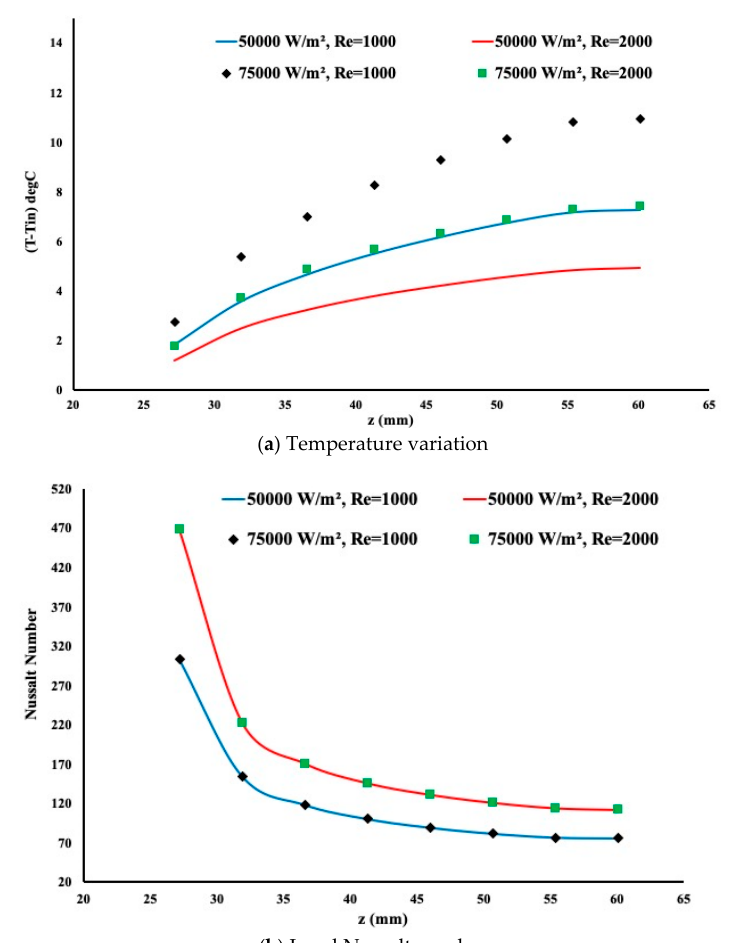
Figure 5. Temperature and the Nusselt number at the inner wall surface with porous media insert.